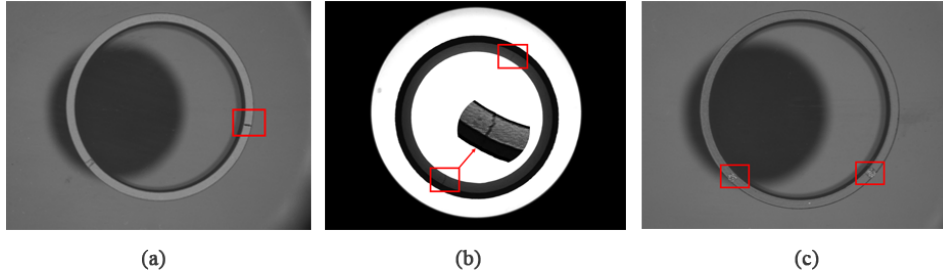
Figure 3. Surface defect detection results of magnetic ring based on the modified YOLOv5s algorithm: ( a ) top cracks, ( b ) inner cracks, and ( c )